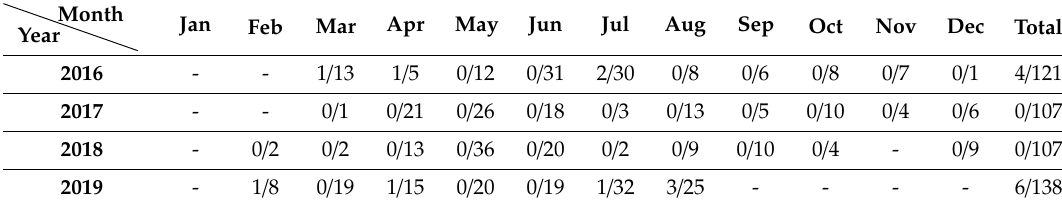
Figure 1. A map of sampling sites for positive samples. Samples were collected from around the country. Positive samples were detected in several provinces, including Gangwon, Chunbuk, Jeonnam and Jeju. In the Pyeongchang and Yeongwol Regions of Gangwon Province, bat paramyxovirus was detected in five and one samples, respectively. In the Danyang and Goesan Regions of Chungbuk Province, bat paramyxovirus was detected in one sample, respectively. In the Hapcheon Region of Jeonnam Province, bat paramyxovirus was detected in one sample. In the Seogwipo Region of Jeju Island, bat paramyxovirus was detected in one sample. Table 2. Number of positive samples in each month from 2016 to